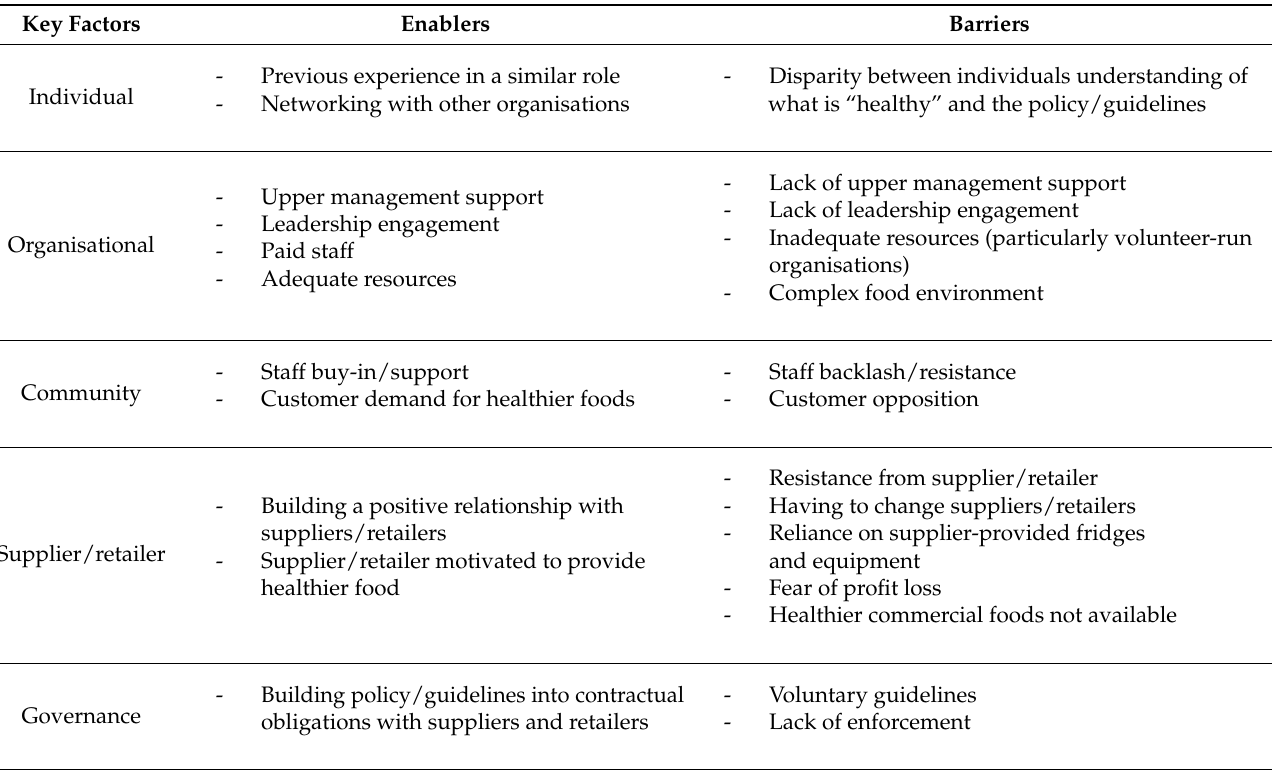
Table 3. Key enablers and barriers influencing